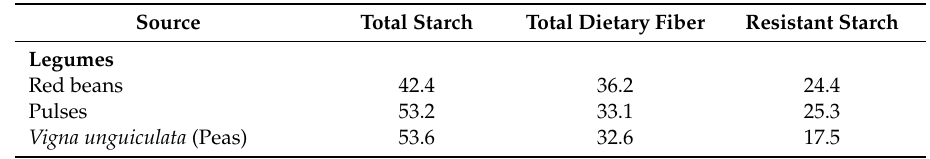
Table 1. Estimated total dietary fiber, total starch, and resistant starch of some nourishment sources (g/100 g as eaten).